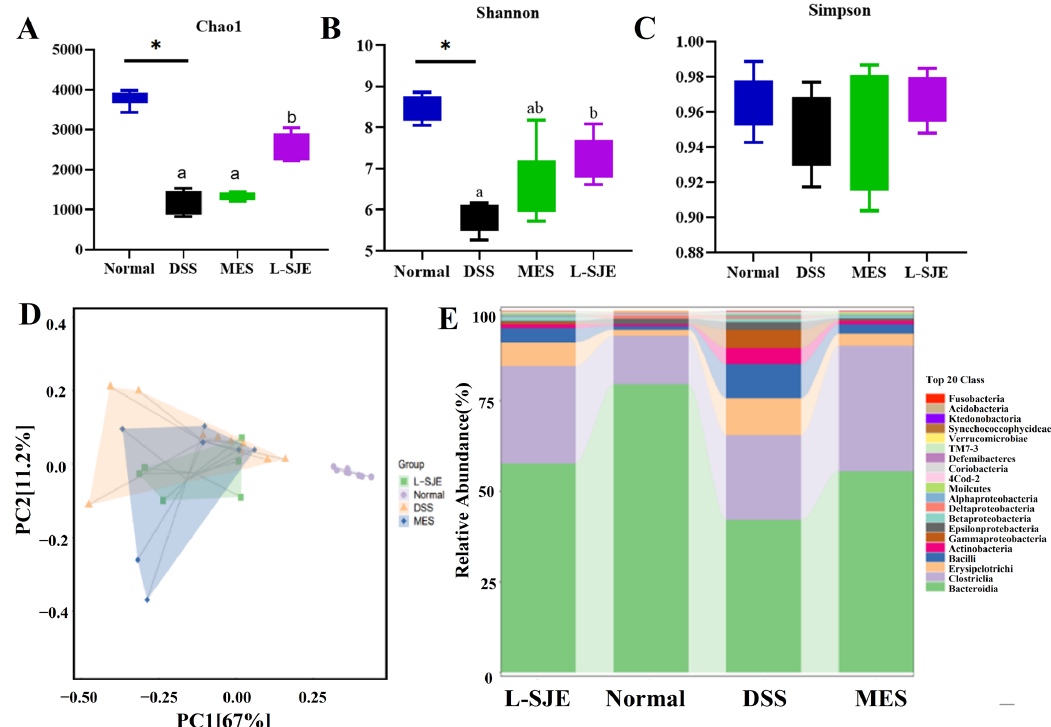
Figure 5. Effects of SJE on gut microbial structure. ( A ) Chao1 index, ( B ) Shannon index, ( C ) Simpson index, ( D ) Principal coordinate analysis (PCA), ( E ) Structure of intestinal microbiota at class level. Different superscript letters (a,b) in the same graph indicate significant differences between groups ( p <